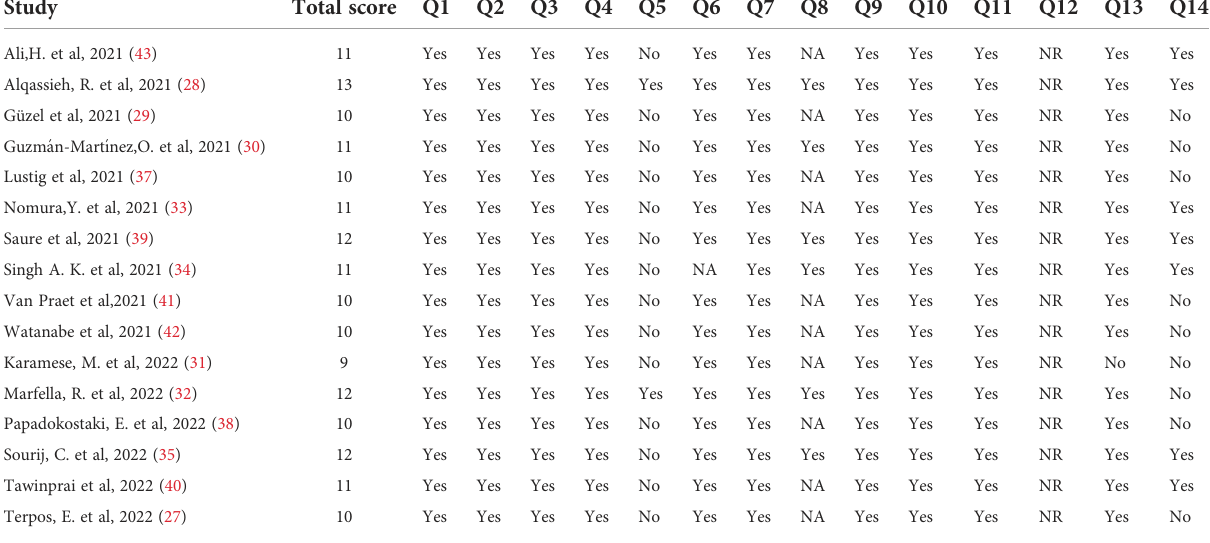
TABLE 2 Quality assessment of the included